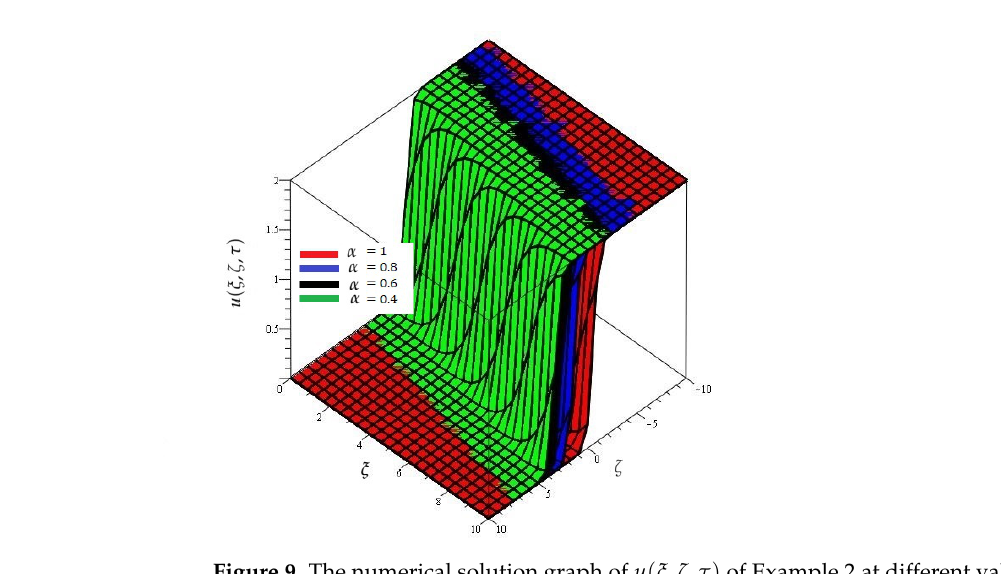
Figure 9. The numerical solution graph of u ( ξ , ζ , τ ) of Example 2 at different value of α .